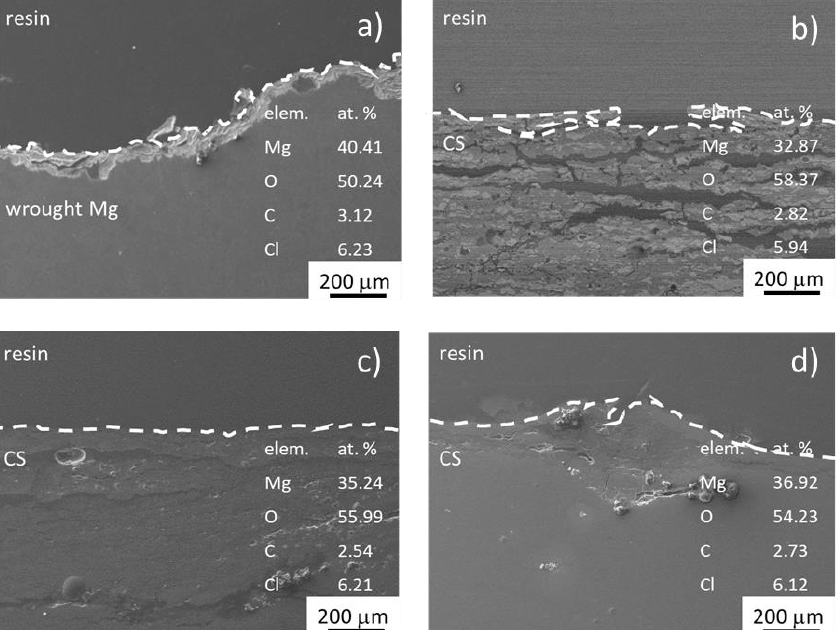
Figure 5. Samples after EIS measurement. The surface of the corroded samples is outlined for convenience: ( a ) wrought pure Mg (different axis scale); ( b ) 500 MPa/RT; ( c ) 100 MPa/400 °C; ( d ) 500 MPa/400 °C.